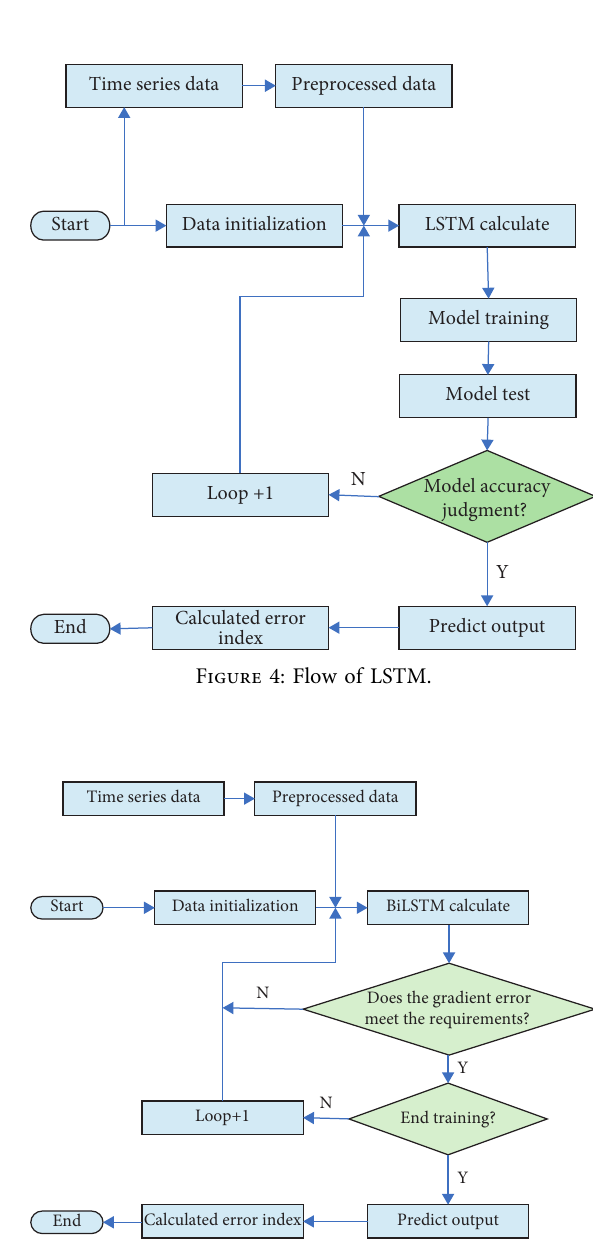
Figure 5: Flow of